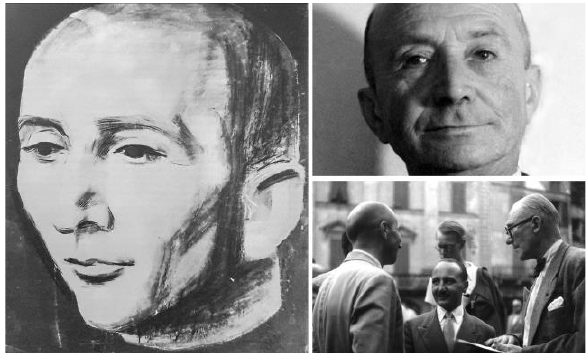
Figure 2. Pino Pizzigoni: two portraits (as a young man and in adulthood) and a photo with Le Courbusier at the CIAM 1949.